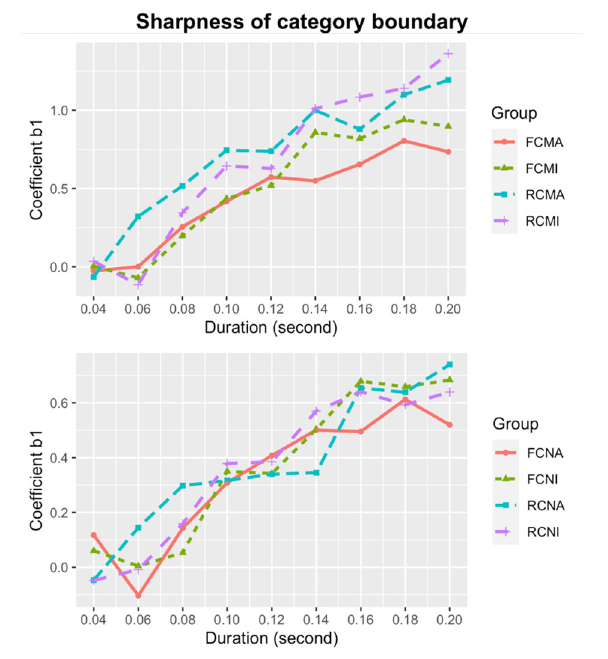
FIGURE 3 | Sharpness of category boundary for Cantonese musicians (upper) and non-musicians